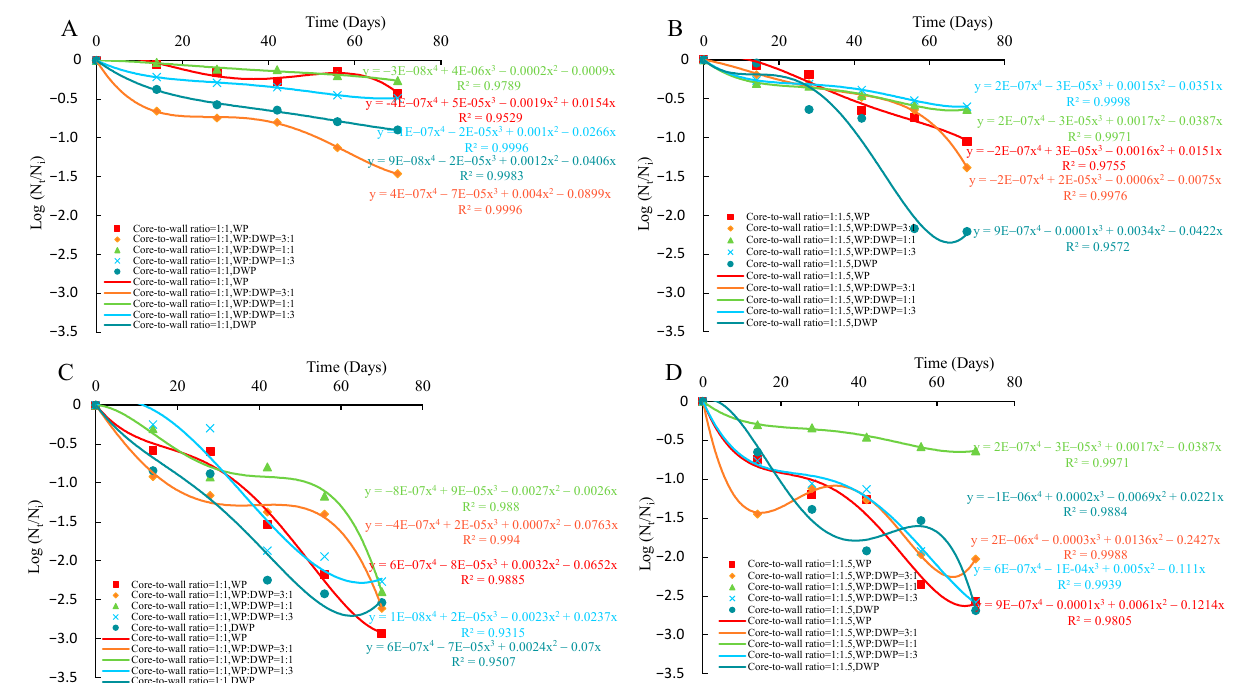
Figure 5. Viability loss of lyophilized L. plantarum 299v strain with core ‐ to ‐ wall ratios and different formulations at 4 °C and 25 °C. A: 4 o C, core ‐ to ‐ wall ratio 1:1; B: 4 °C, core ‐ to ‐ wall ratio 1:1.5; C: 25 °C, core ‐ to ‐ wall ratio 1:1; D: 25 °C, core ‐ to ‐ wall ratio 1:1.5. WP: whey protein, DWP: denatured whey protein.